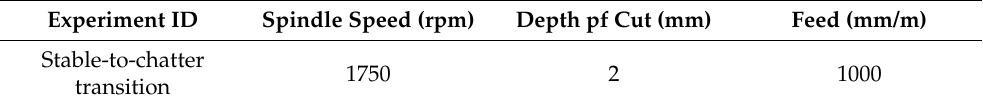
Table 3. Cutting parameters for case 2.